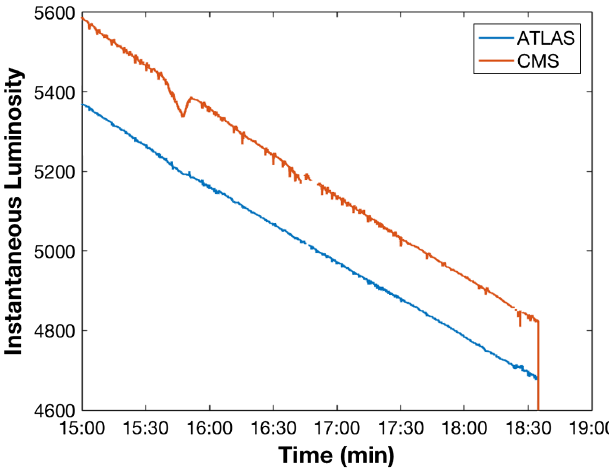
FIG. 18. Average klystron forward power. 2220 bunches, beam 1.